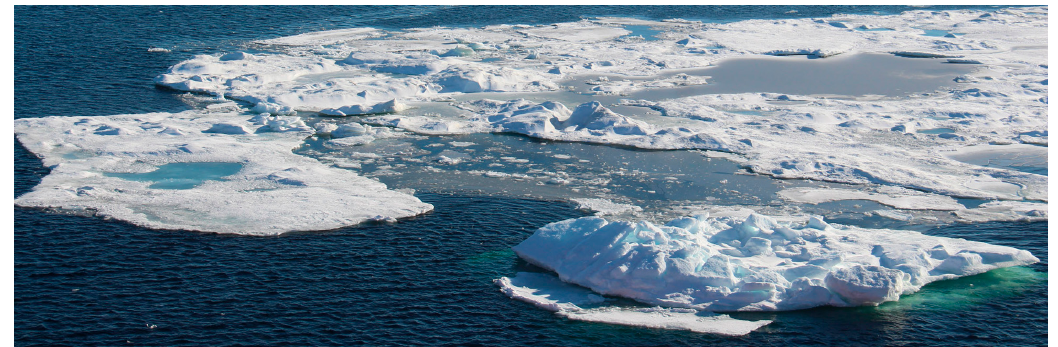
Figure 11. Photo of 27 August 2016, taken on board RV Akademik Tryoshnikov in the Laptev Sea at 75.56 N, 126.84 E (by T.A. Alekseeva).